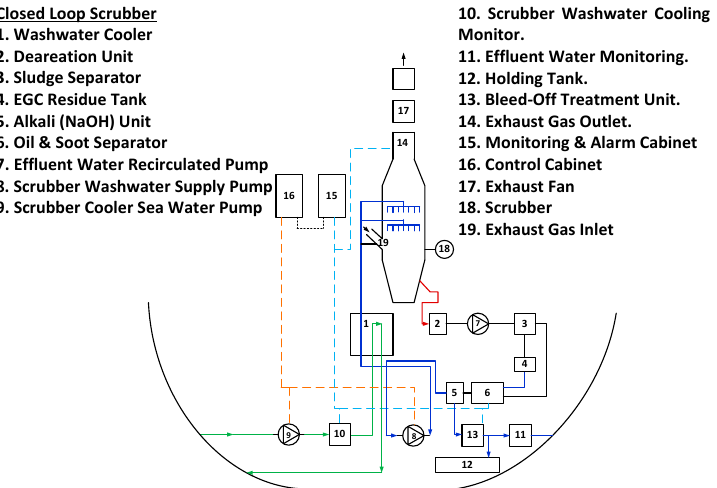
Figure 2. Schematic view of the on-board installation of a closed-loop wet SO x scrubbing system operating with a freshwater solution of NaOH. (Figure was genuinely generated using data from ref. [29]).